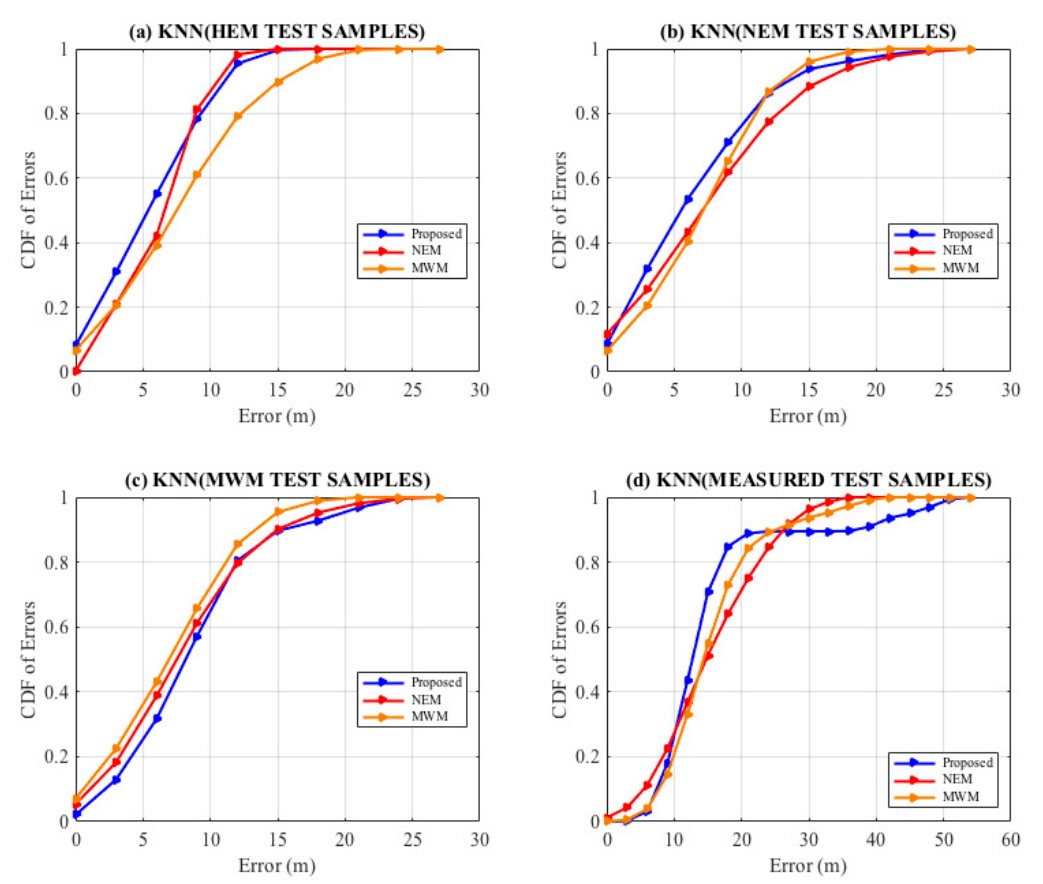
Figure 8. Localization. KNN Comparison by diverse predicted test samples. Table 12. KNN with HEM Simulated Test Samples.